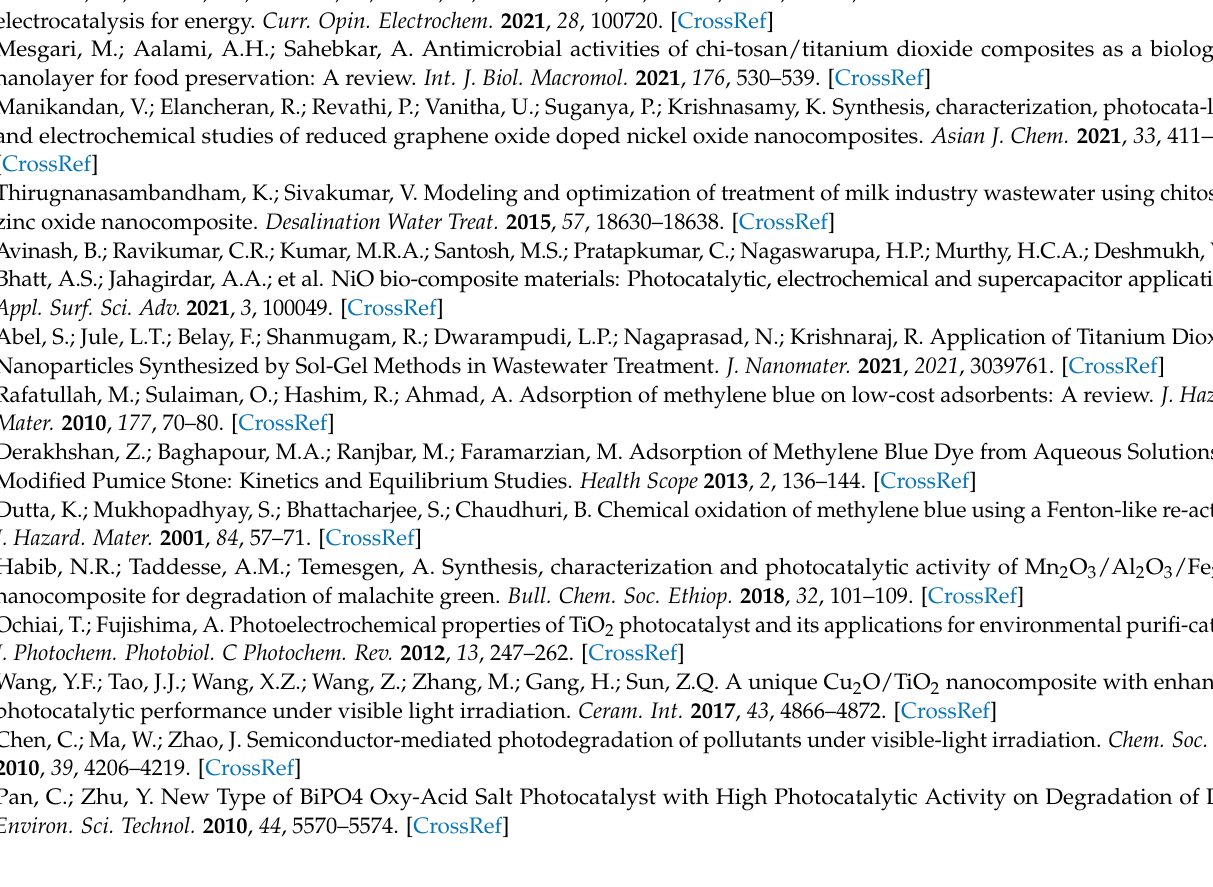
Table S1: Absorbance and % degradation of dye with respect to time in presence of different catalyst weight; Table S2: Reusability study of